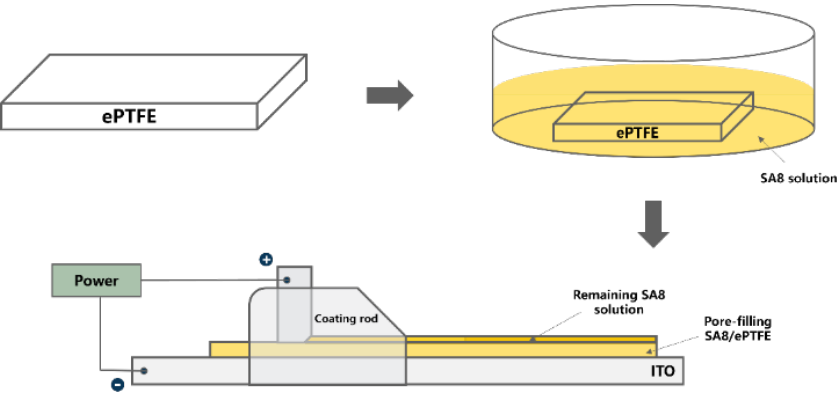
Figure 2. Production of the polymer membrane.